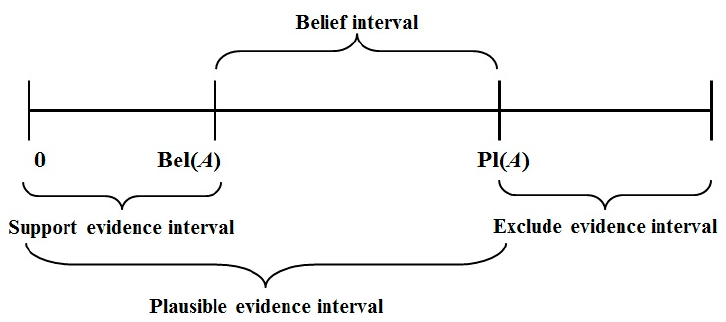
Figure 6. The uncertainty interval measured by the belief and plausibility functions.